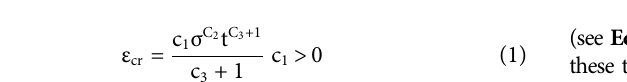
Frontiers in Energy Research |